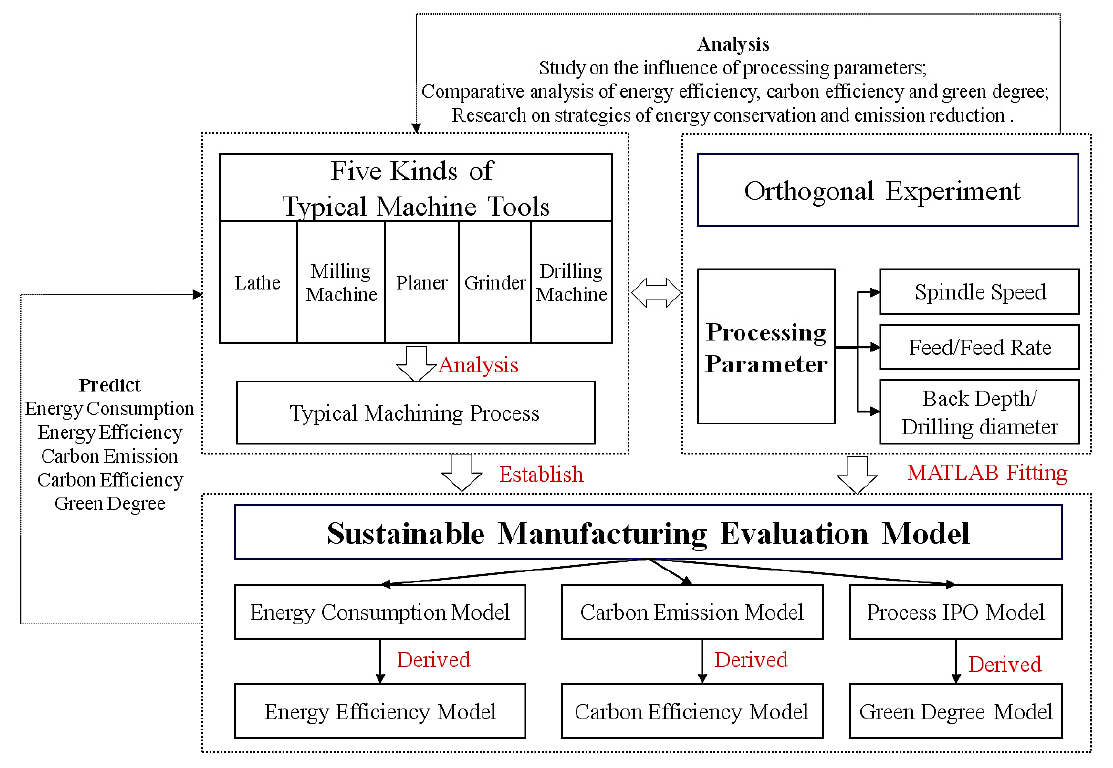
Figure 1. Research Figure 1. Research approaches.